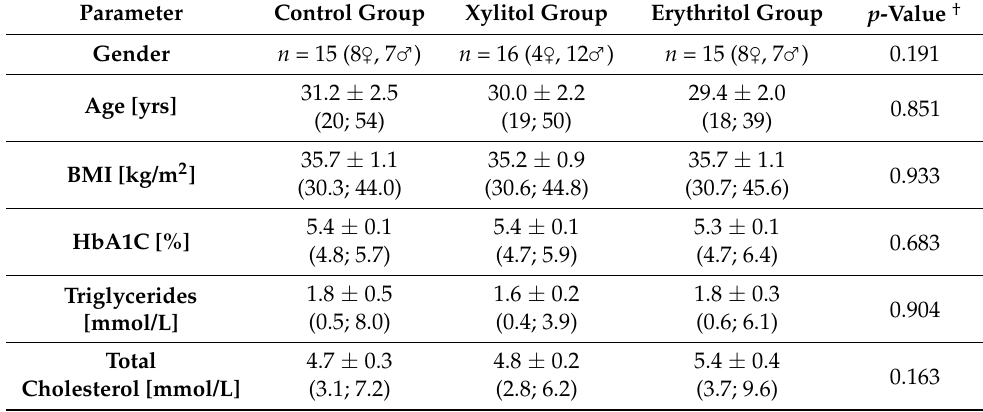
Table 1. Demographic characteristics and biochemical parameters (mean ± SEM (range)).